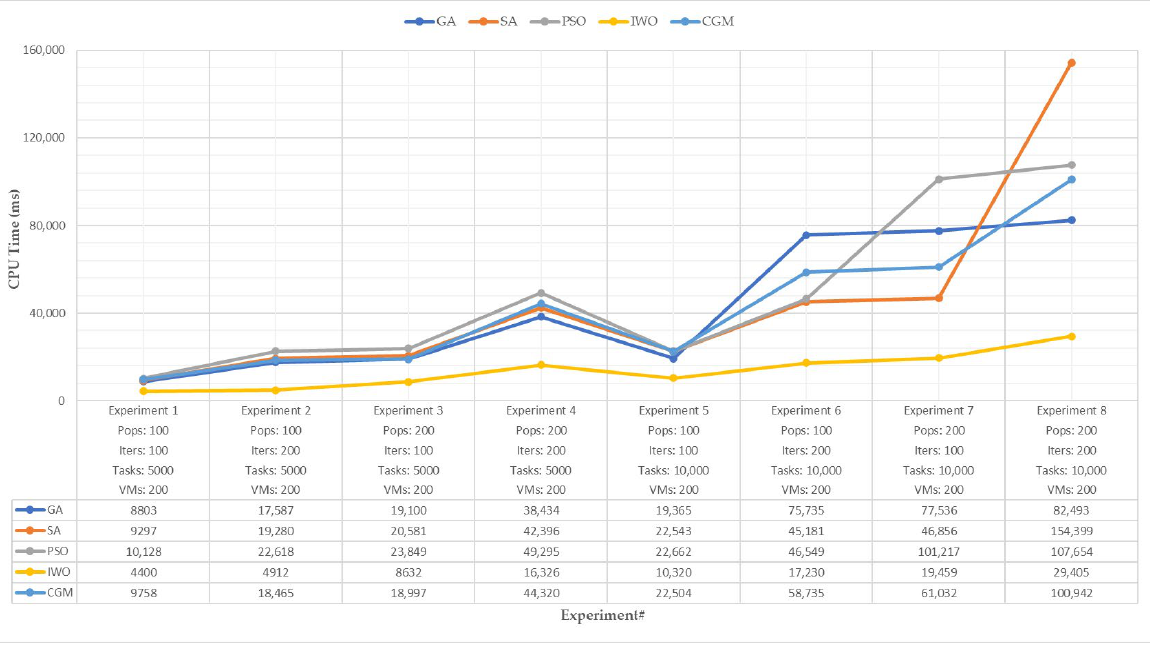
Figure 21. Evaluation results of execution time (CPU time) criterion for the BoT scheduling problem with large parameters (in milliseconds)